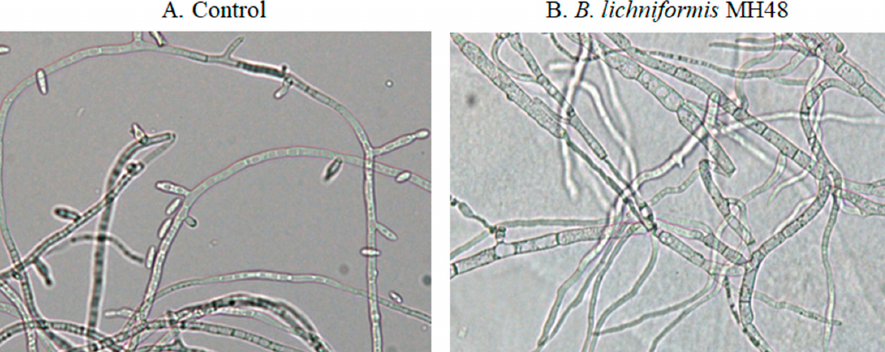
Figure 3. Effect of chitinase and β -1,3-glucanase produced by B. licheniformis MH48 on hyphal deformation of F. oxysporum ( B ) and the control ( A ) under light microscope.